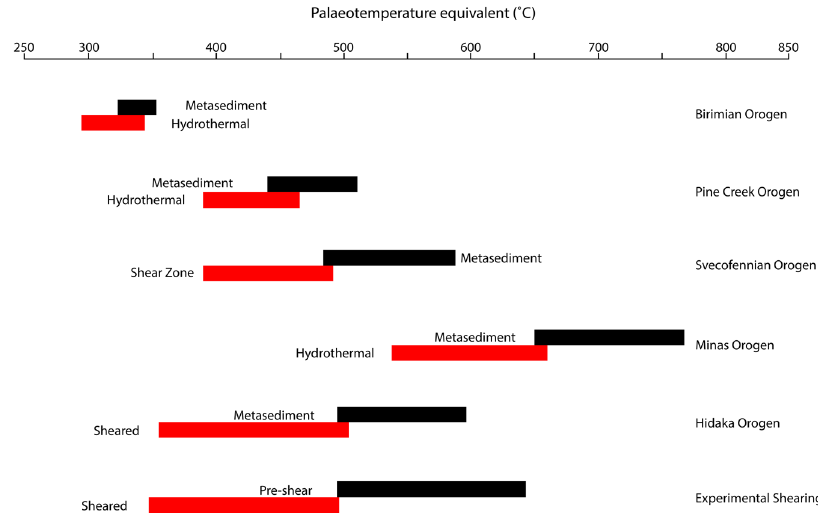
Fig. 6 Comparison of degree of order in graphitic components in metamorphic country rock and fault rock. Order is expressed as palaeotemperature equivalent, which increases with an order. Data are shown for four Palaeoproterozoic orogens 38,41 – 43 , and sheared rocks in young Hidaka Orogen 40 and laboratory experiment 52 for comparison. Orogens show decrease in order in fault rocks (red colour) relative to the original metasediment (black colour).